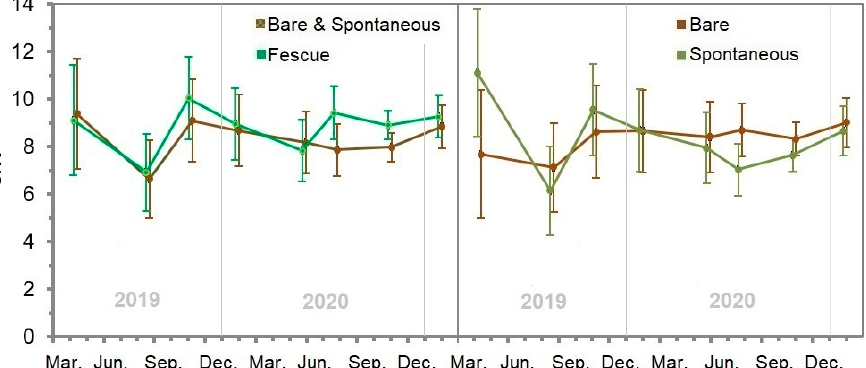
Figure 10. Soil carbon to nitrogen ratio, i.e., w SOC / w N (C/N), at 0–20 cm in the different treatments throughout the monitoring time alongside the 95% confidence interval for the means according to the orthogonal contrasts based on the one-way ANOVA results for each sampling time.